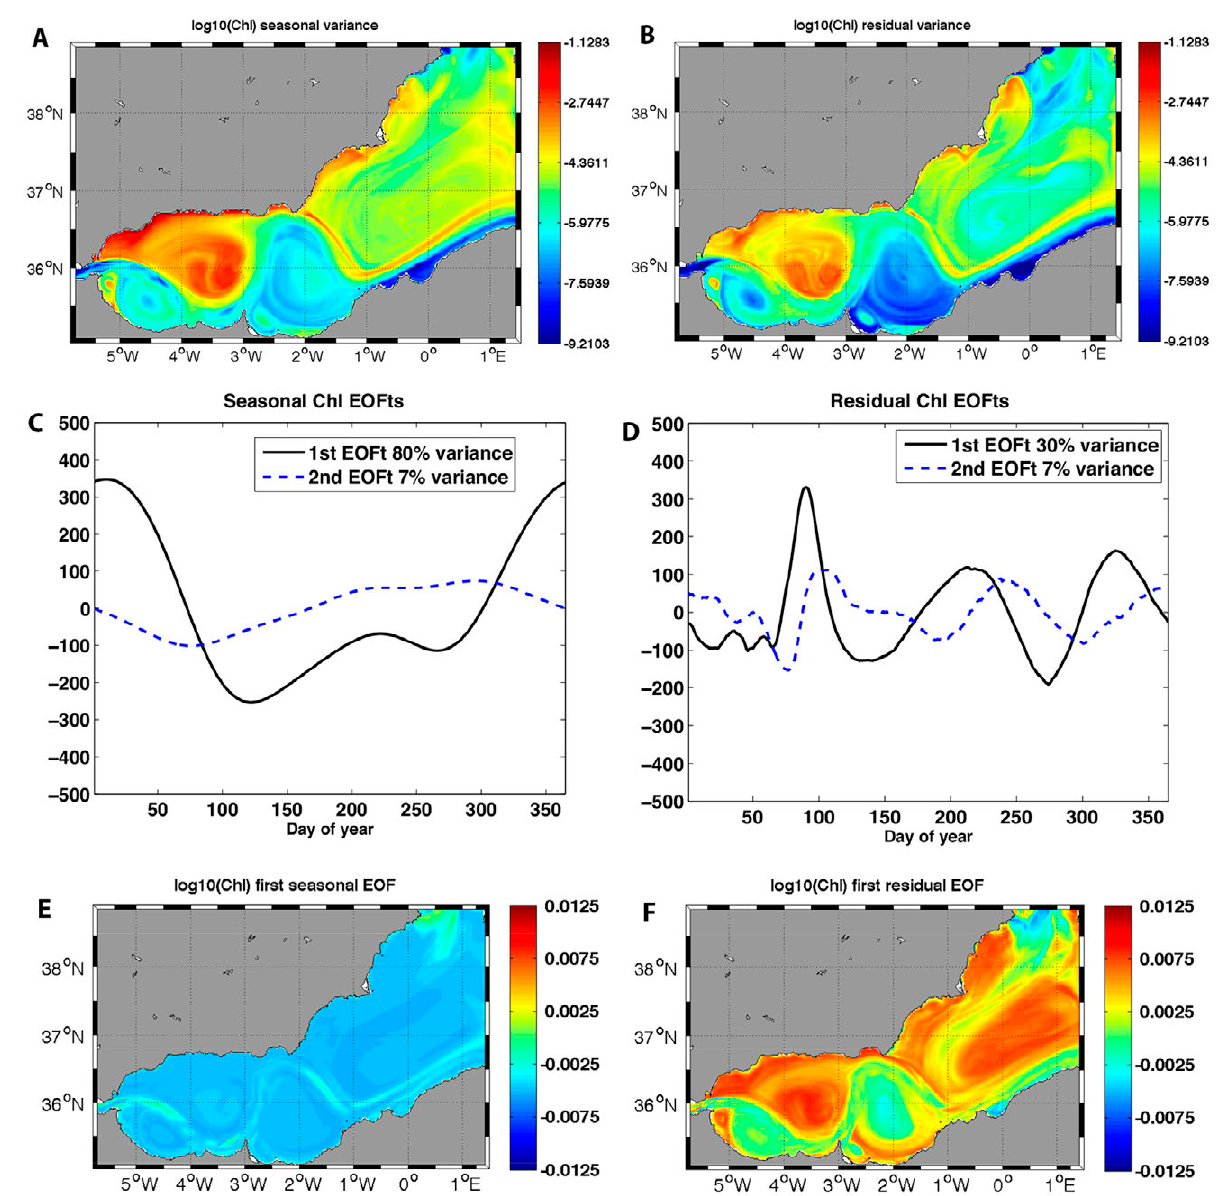
Fig. 2. – A, Chl a seasonal part variance, colour in logarithmic scale; B, Chl a residual part variance, colour in logarithmic scale; C, chlorophyll seasonal part first and second EOFts; D, Chl a residual first and second EOFts; E, Chl a first seasonal EOF; F, Chl a residual first